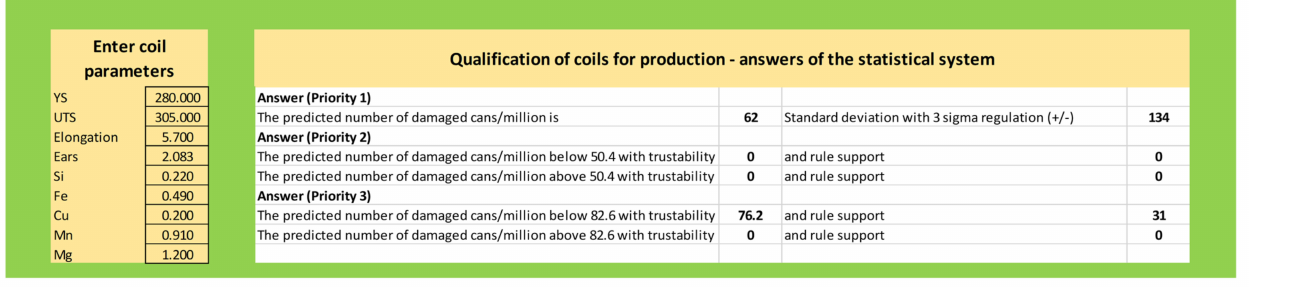
Figure 14. Tool for predicting the number of short cans for new